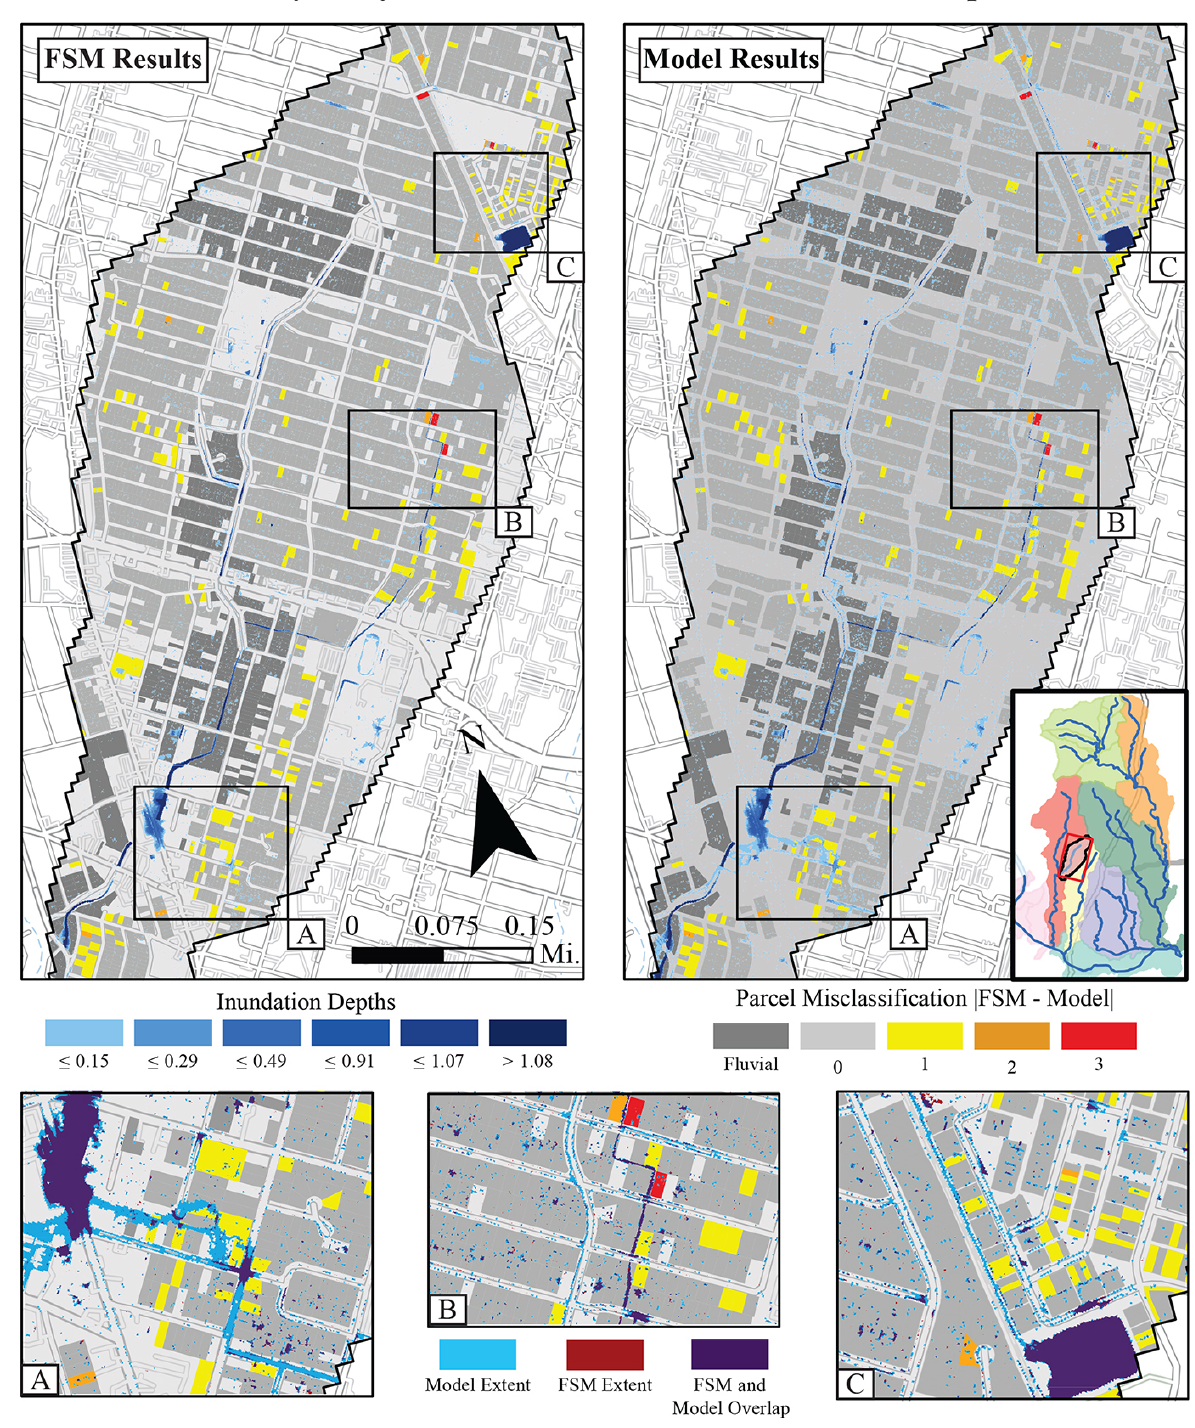
Figure 3. Comparison between near real-time estimate (Fill–Spill–Merge) and a 2D physical based hydrodynamic model estimate of pluvial flooding at the parcel level. (a) – (c) highlight areas with concentrated parcel misclassifications. Parcel misclassification is defined as the absolute value of the difference between a parcel’s hazard class when determined with either a Fill–Spill–Merge (FSM) or the hydrodynamic